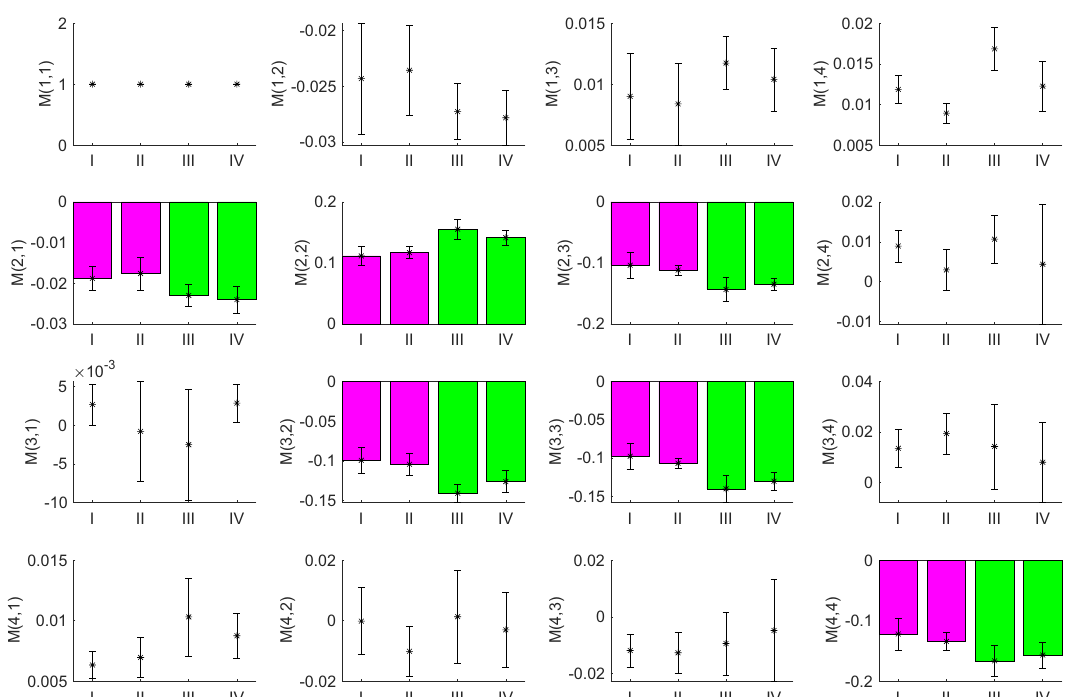
Figure 5. Mean values of the MM images from a series of measurements on porcine corneas. The measurements were performed on corneas neither prepared with riboflavin nor irradiated with UV (I), not prepared with riboflavin but irradiated with UV (II), prepared with riboflavin but not irradiated with UV (III) and both prepared with riboflavin and irradiated with UV (IV). The error bars represent the standard deviation for the sample size used as derived from multiple measurements. The elements M ( 2,1 ) , M ( 2,2 ) , M ( 2,3 ) , M ( 3,2 ) , M ( 3,3 ) and M ( 4,4 ) , highlighted by bar plots show a clear difference between the samples with and without riboflavin treatment.